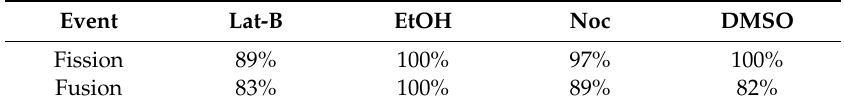
Table 1. Localization of FszB-GFP during fission and fusion events with an altered cytoskeleton. The table indicates % of events that FszB-GFP is present at. Statistically FszB-GFP is mis-localized during fusion events treated with DMSO, p = 0.0557, n = 30